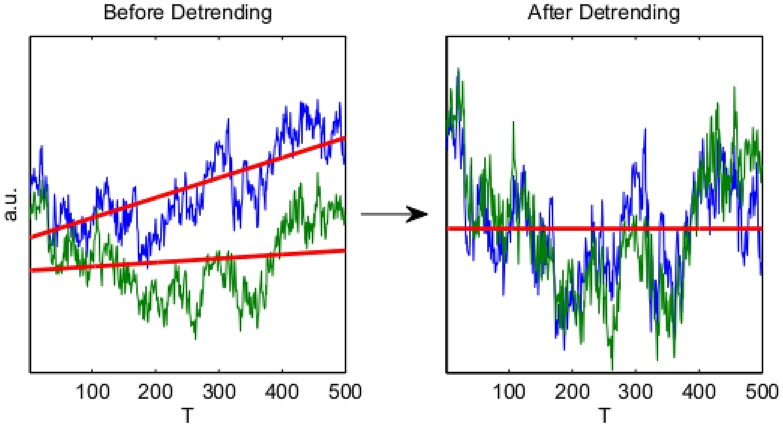
Illustration of DCCA.DCCA is the exact analogy of DFA (see Fig 10) for two time-series. The left hand panel displays the cumulative sum of two time-series; the right hand panel displays the same time-series after detrending. The strong correlation between the time-series only becomes apparent after detrending, explaining the advantage of DCCA for long-range dependent and non-stationary time-series.